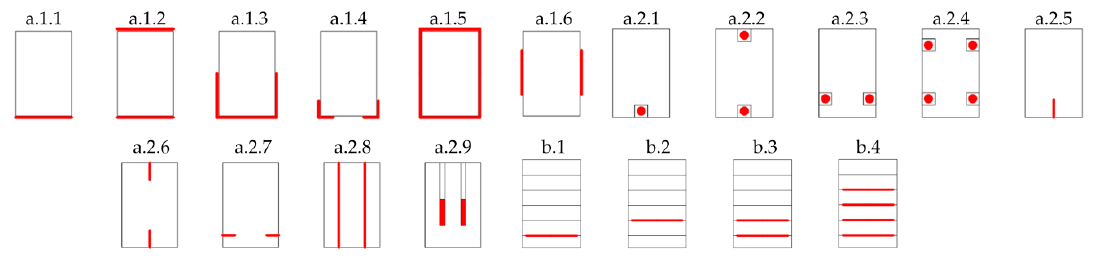
Figure 1. Summary of FRP (fiber reinforced plastics) reinforcement layouts (in red).